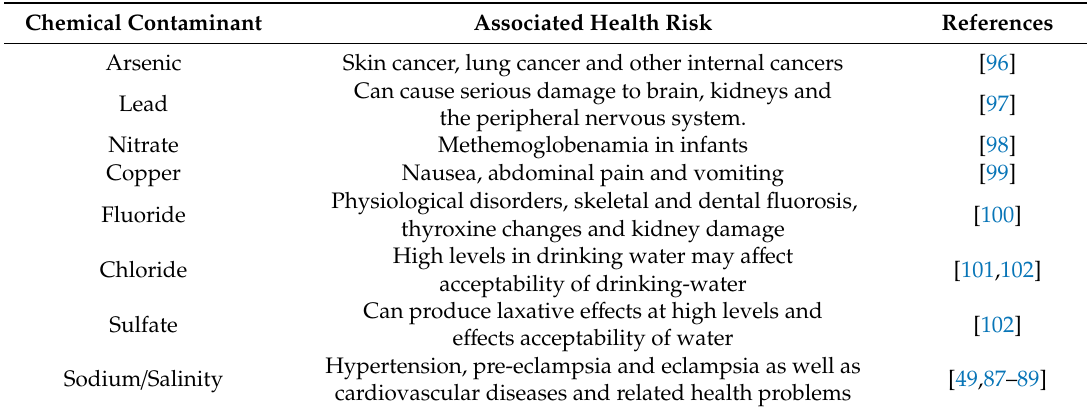
Table 3. Potential health impacts of major physico-chemical contaminants in developing countries including